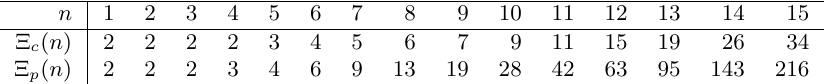
Table 3: The number, Ξ , of components in the state graph of the ESPD on a cycle of order c ( n ) n , for small values of n , if (3) holds. The corresponding number, Ξ p ( n ) , of components, taken from [1, Table 4.2], for the ESPD on a path of order n is also shown for purposes of